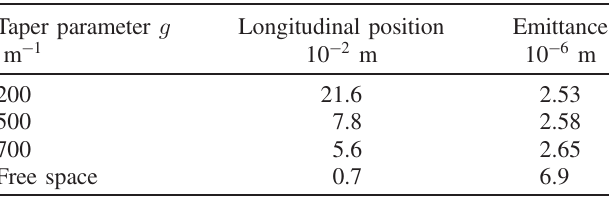
TABLE II. Comparison of beam parameters at equal transverse size of 0.02 mm corresponding to a beam expansion by a factor of 40.